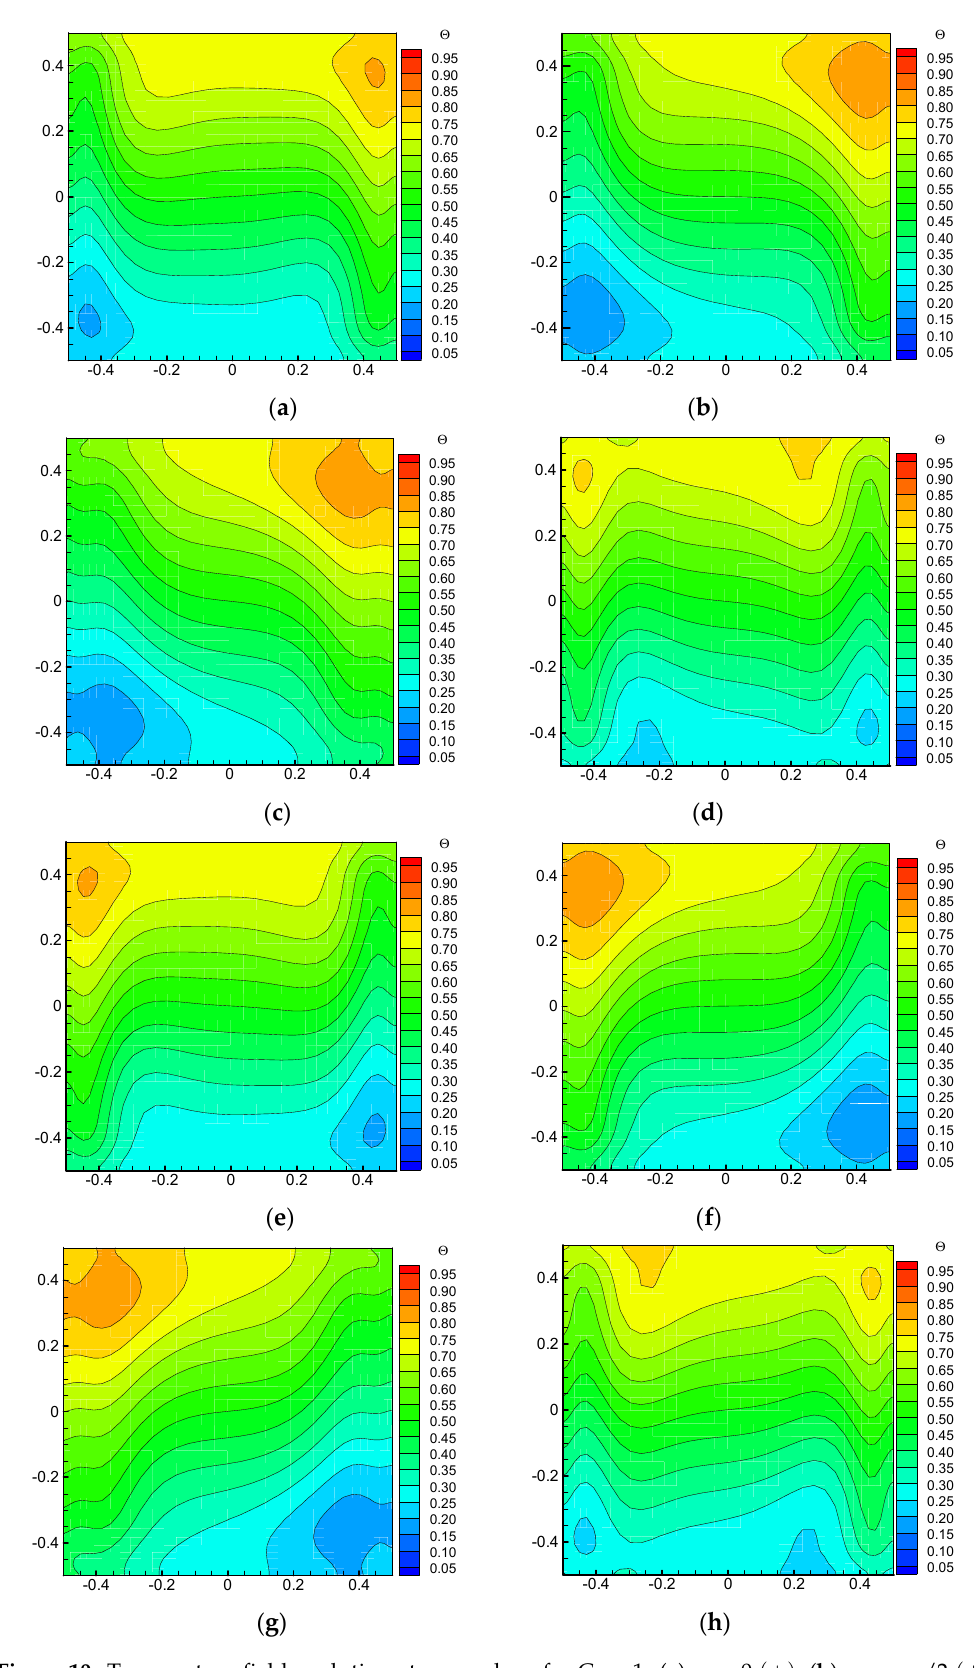
Figure 10. Temperature field evolution at x-o-z plane for Case 1: ( a ) ϕ = 0 (+) ; ( b ) ϕ = ϕ m /2 (+) ; ( c ) ϕ = ϕ m ; ( d ) ϕ = ϕ m /2 ( − ) ; ( e ) ϕ = 0 ( − ) ; ( f ) ϕ = − ϕ m /2 ( − ) ; ( g ) ϕ = − ϕ m ; ( h ) ϕ = − ϕ m /2 (+)